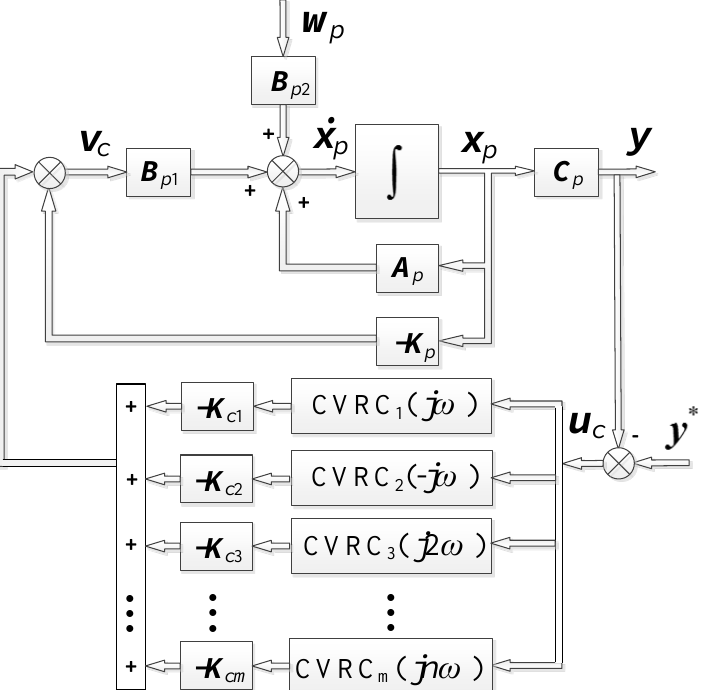
Figure 3. Closed - loop control structure of the system.